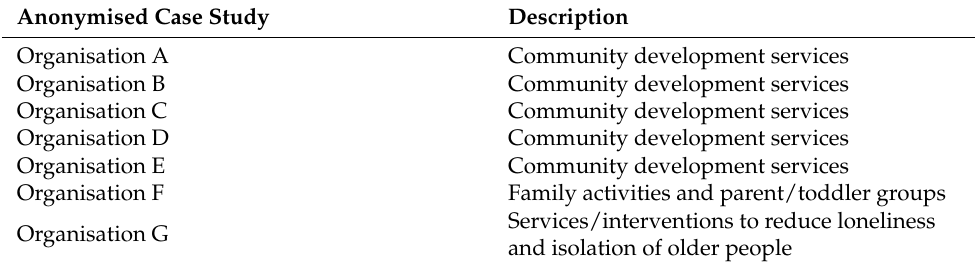
Table 1. Case study